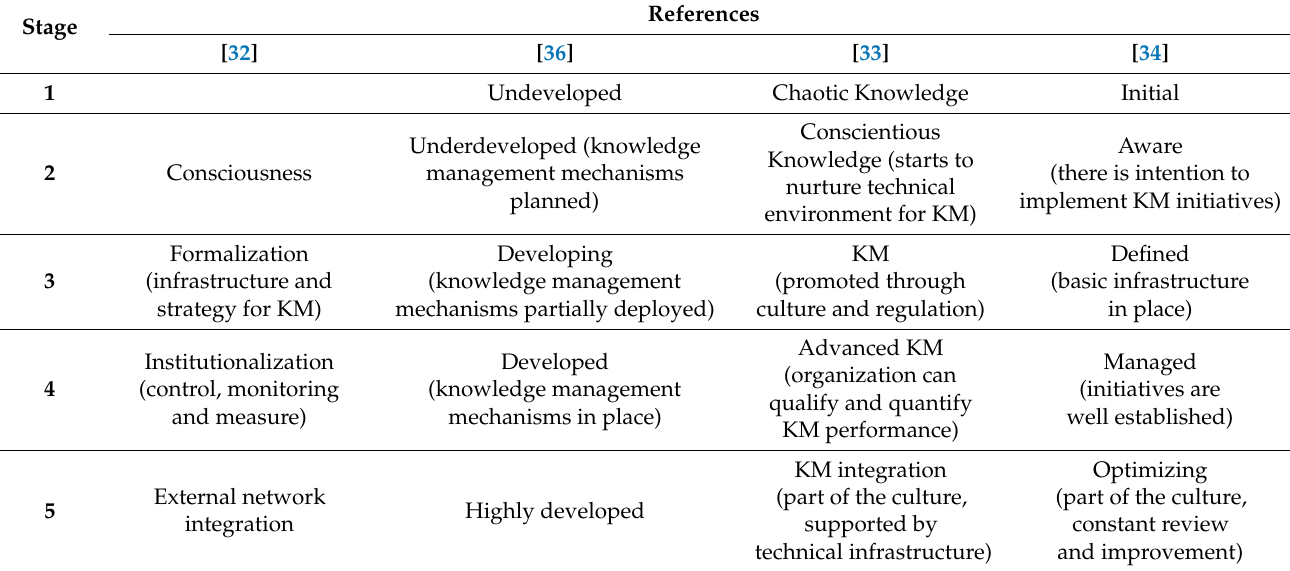
Table 1. Knowledge management maturity